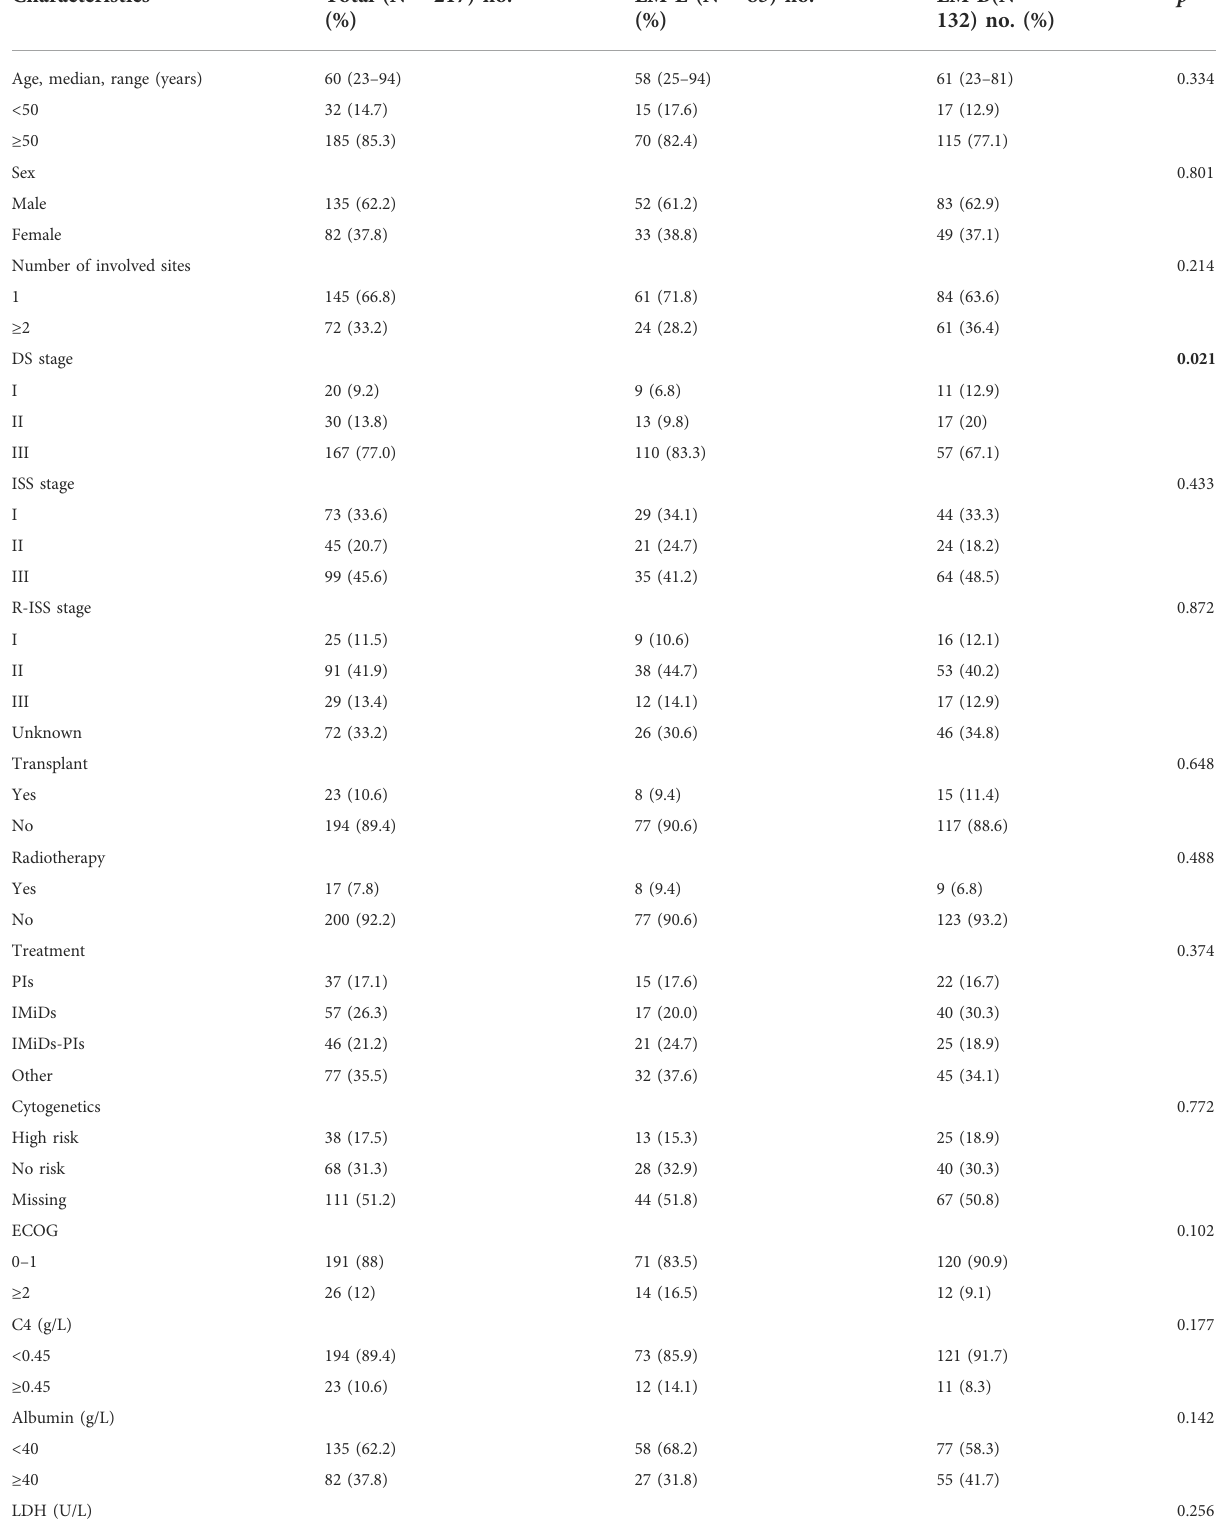
TABLE 1 Clinical characteristics of patients with extramedullary multiple myeloma.